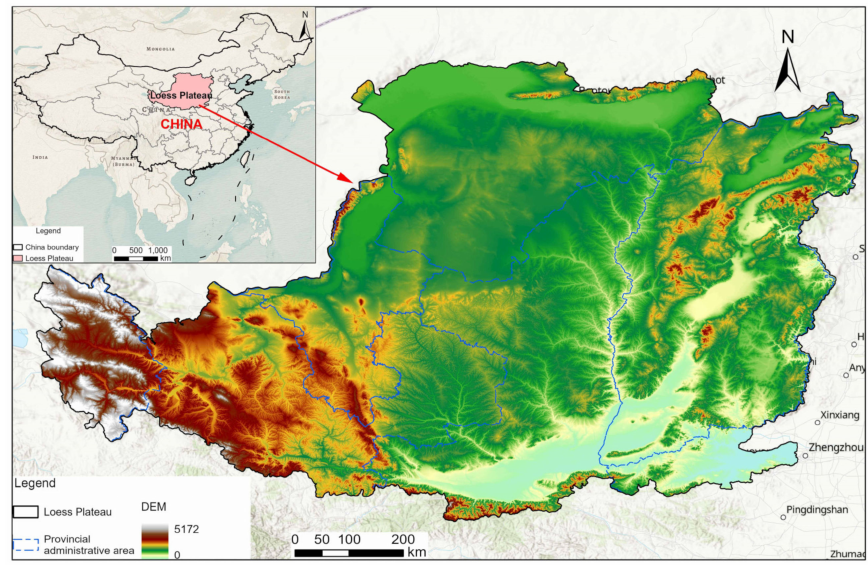
Figure 1. Location and topography of